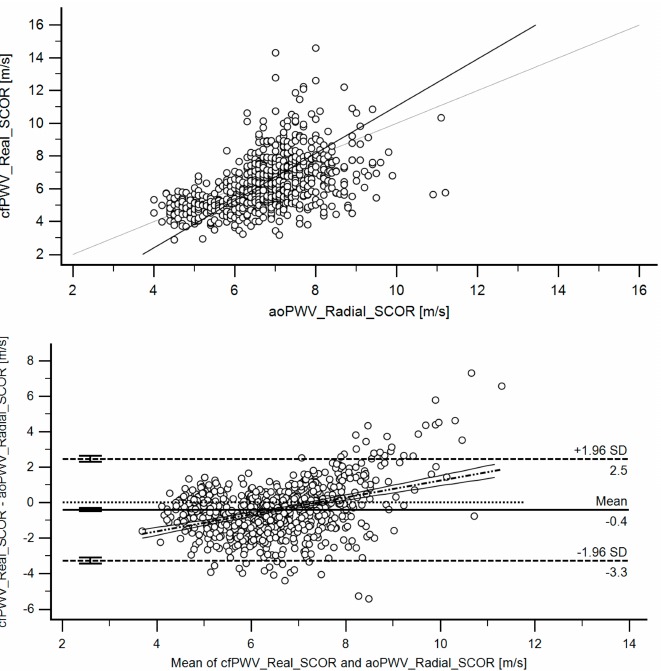
Figure 3. Top : Association (scatter diagram) between cfPWV_RealSCOR and aoPWV_Radial-SCOR for the RI Group. r: 0.4980 (95% C.I.: 0.4429–0.5493). p < 1.0 × 10 − 14 . Bottom : Bland–Altman diagram. There were statistically significant mean ( − 0.41 m/s) and proportional errors. Table 5 (Part 1) shows quantitative